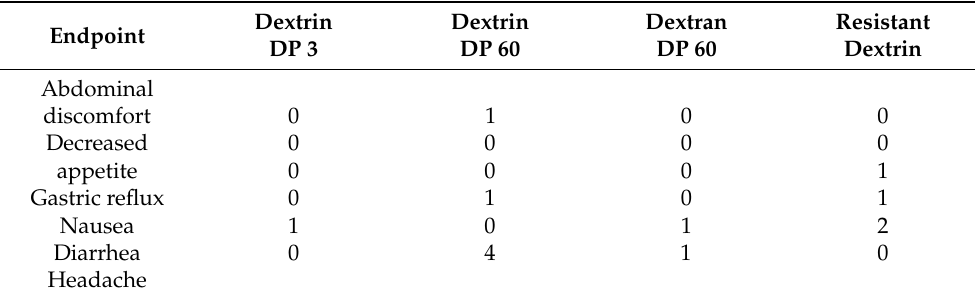
Table 4. Gastrointestinal tolerance: number of subjects out of 10 reporting symptoms with a score > 20 on a visual analogue scale